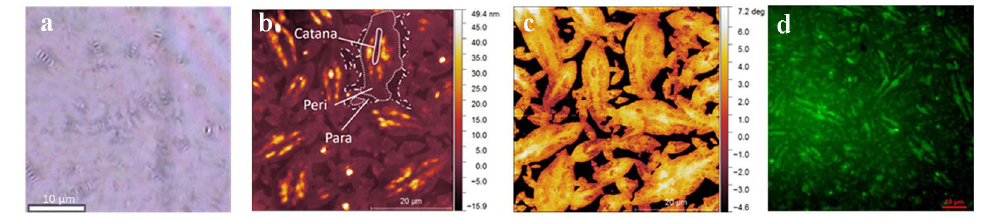
Figure 1. Bitumen surface demonstrated with various microscopic techniques. ( a ) Light microscopy, ( b ) AFM (topography image), ( c ) AFM (phase image) highlighting catana, peri and para phase and ( d ) fluorescence microscopy showing brightly fluorescing